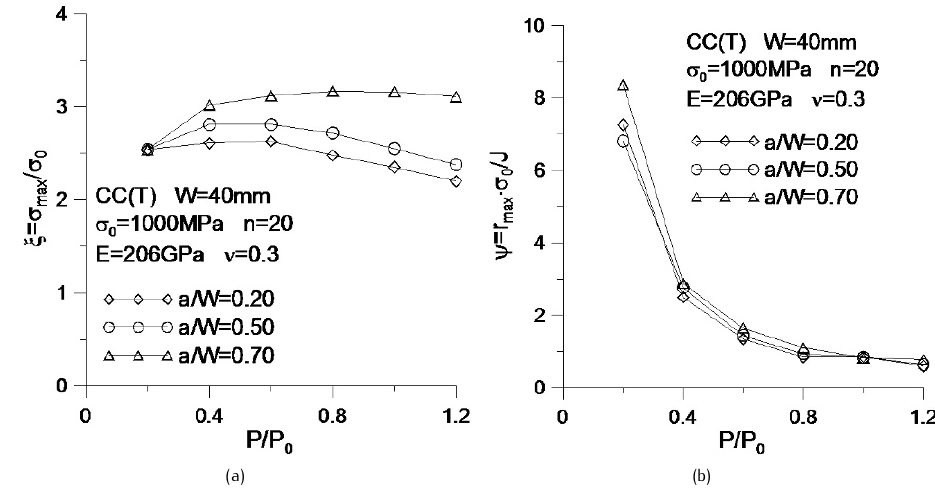
Figure 12. The influence of the normalized crack length on maximum opening stress value σ max /σ 0 (a) and their normalized location near crack tip ψ = r max · σ MPa, n = /J (b) for CC(T) specimen – σ 0 0 = 1000